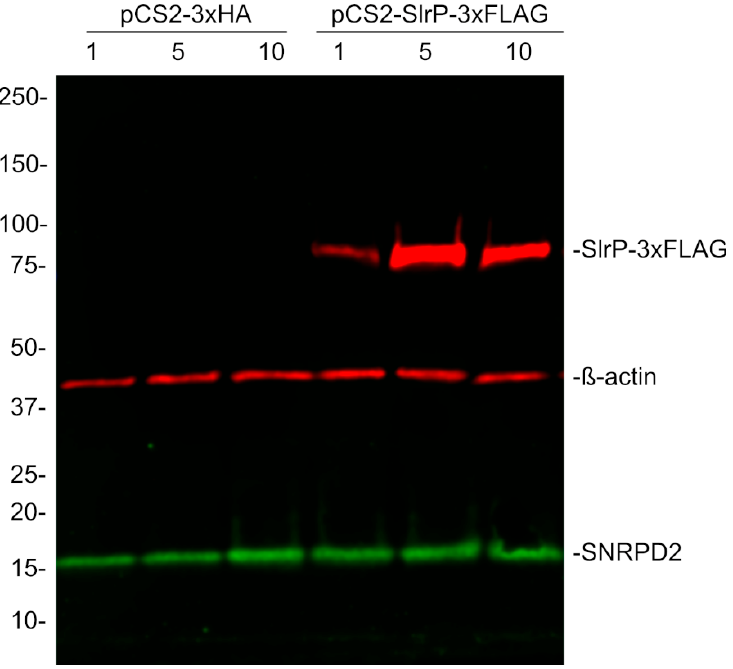
Figure 7. Stability of SNRPD2 in the presence of SlrP. HEK293T cells were transfected with 1, 5 or 10 μ g of plasmids pCS2 or pIZ1720 (pCS2-SlrP-3xFLAG), as indicated. The level of SNRPD2 was detected by Western blot with anti-SNRPD2 antibodies. Expression of SlrP-3xFLAG was detected with anti-FLAG antibodies. Anti- β -actin antibodies were used as loading control. Sizes of molecular weight markers are shown in kDa. Results are representative of three independent experiments.